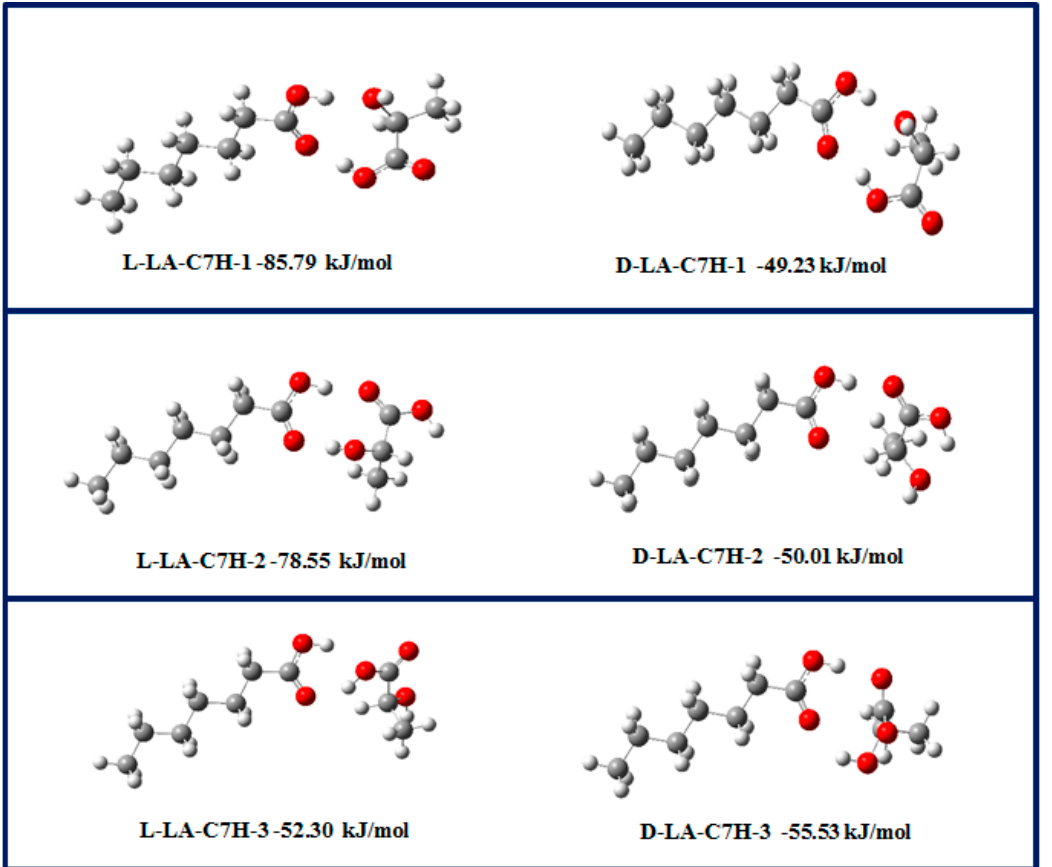
Figure 5. The dominant 1:1 H-bonding interaction geometries between fatty acid and L/D-LA at the B3LYP/6-31G (d, p) level along with the corresponding H-bonding energies at the M06-2X/6-311 + G(d, p)//B3LYP/6-31G(d, p) level.